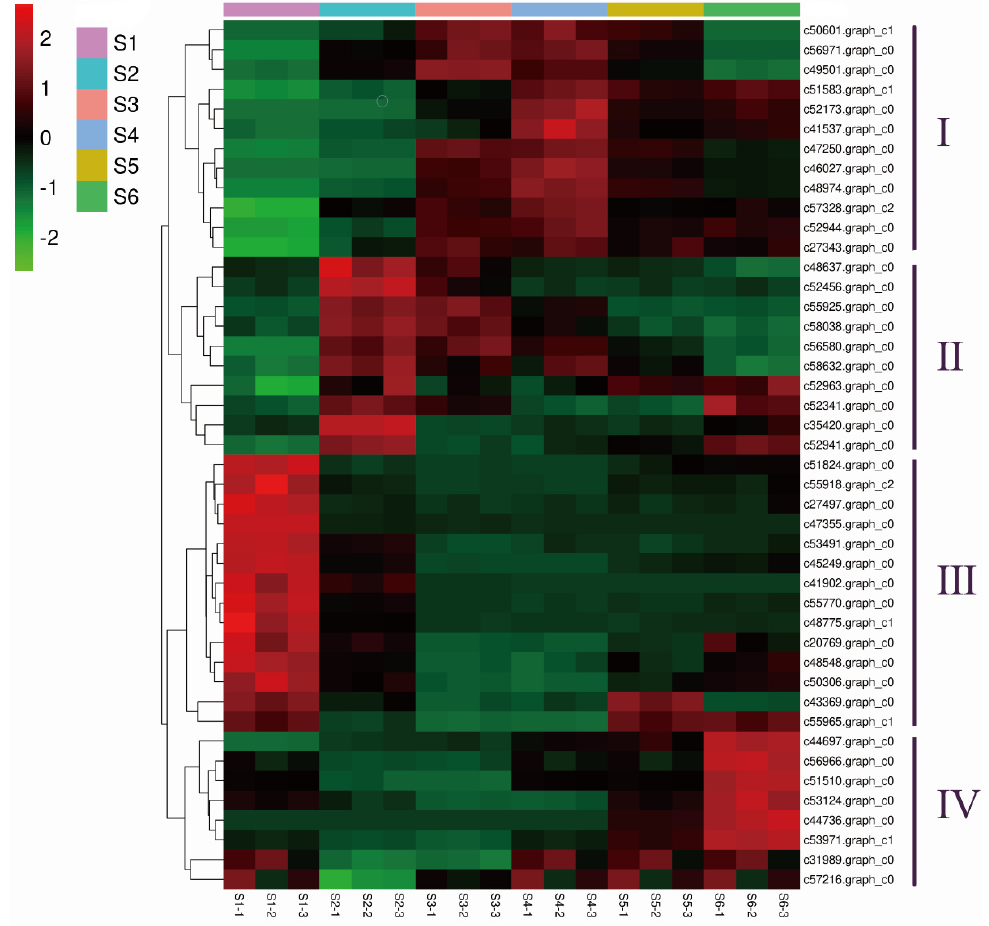
Figure 13. Heatmap showing the relative expression of the differentially expressed genes (DEGs) in the developing xylem of “Shanxin” poplar. The rows and columns in the heat map represent the gene IDs and the six samples, respectively.